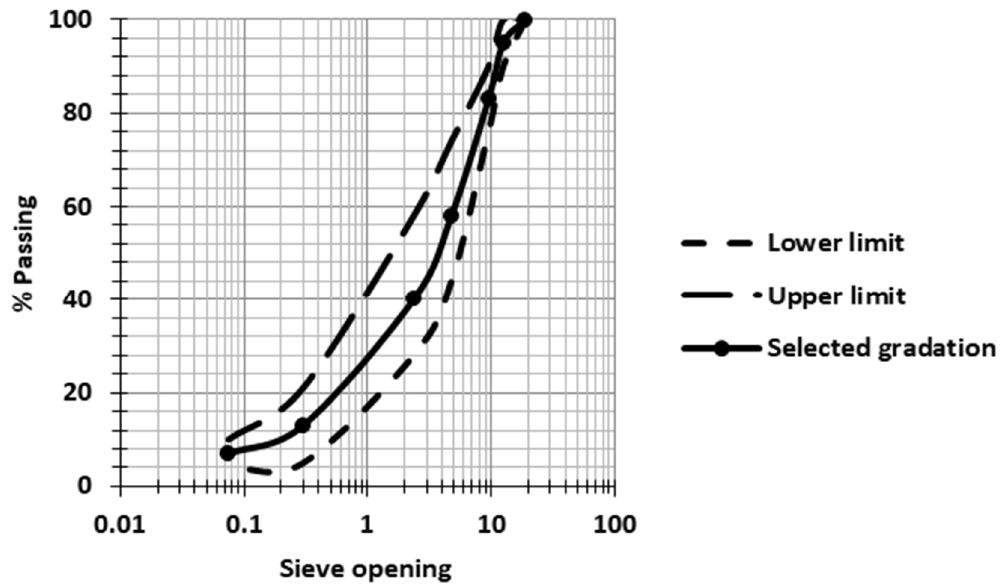
Figure 1. Grading of aggregate per Iraqi SCRB standards [28]. Table 5. Selected gradation of aggregate.